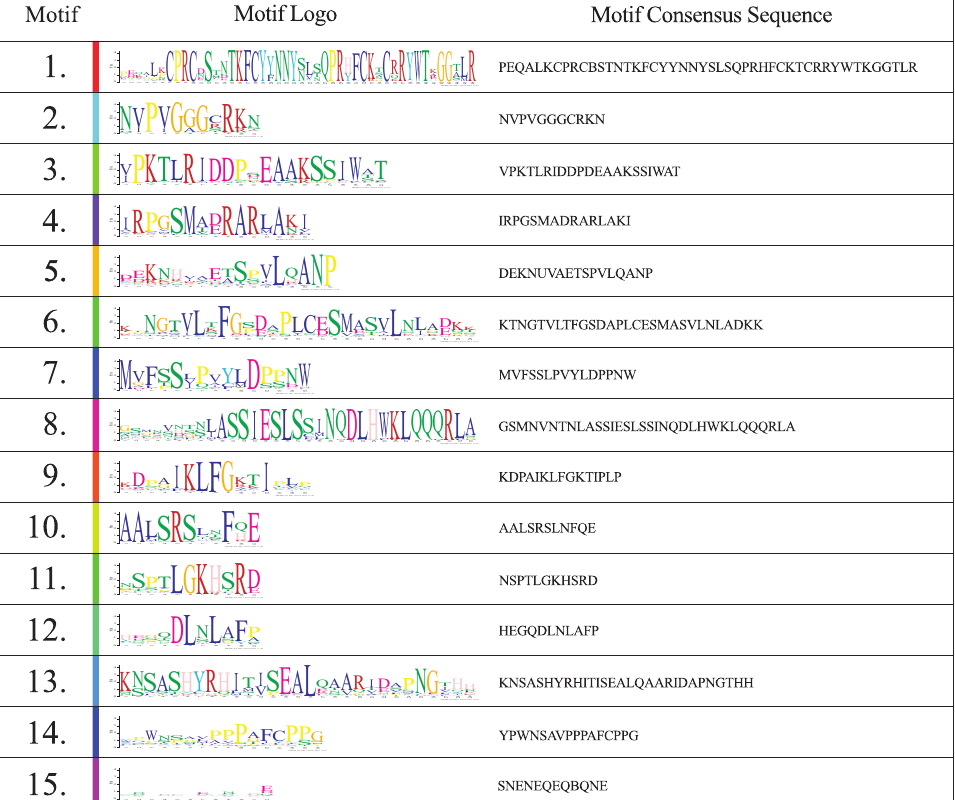
Figure 4. Conserved protein motifs identified in Eugenia uniflora DOF genes. Motifs are ordered based on false discovery rate, from lowest to